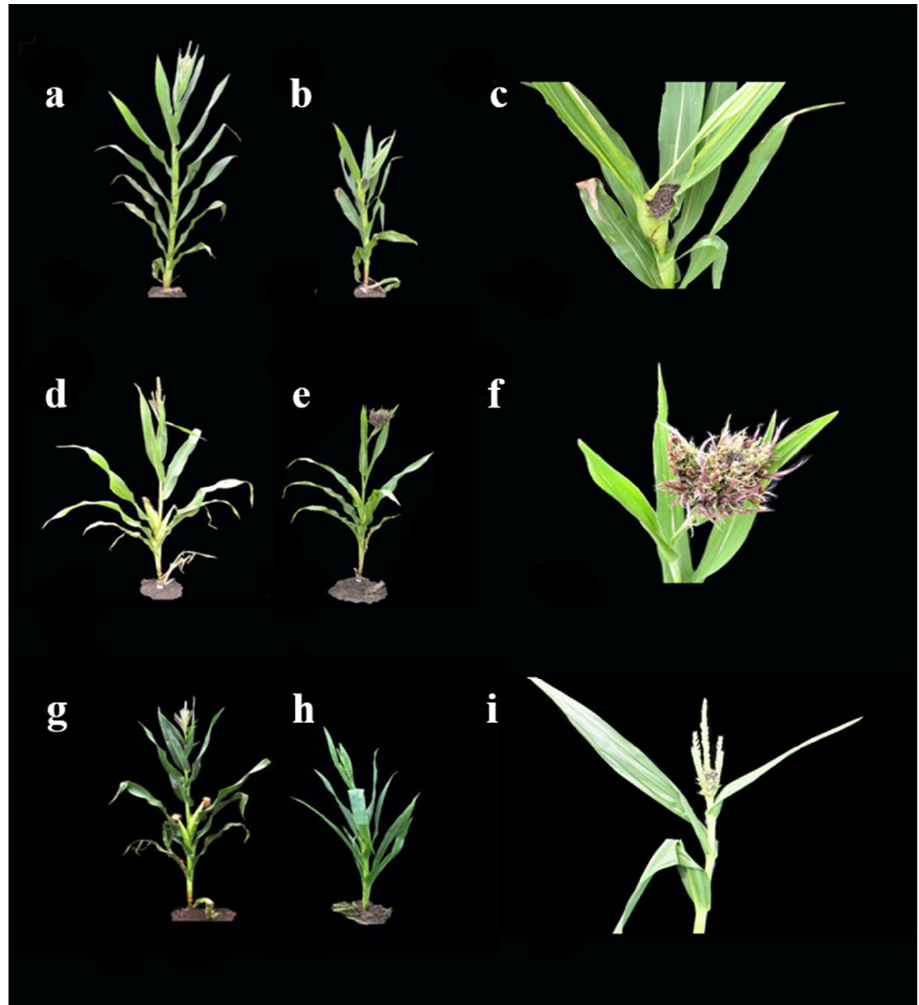
Figure 2. Three types of tassel symptoms in typical maize inbred lines infected with Sporisorium reilianum : ( a ) Huangzao4 normal plant without Sporisorium reilianum ; ( b ) Huangzao4 plant infected with Sporisorium reilianum ; ( c ) Class A with typical symptoms of the tassel of Huangzao4; ( d ) Jing7 normal plant without Sporisorium reilianum ; ( e ) Jing7 plant infected with Sporisorium reilianum ; ( f ) Class B with typical symptoms of the tassel of Jing7; ( g ) Chang7 ‐ 2 normal plant without Sporisorium reilianum ; ( h ) Chang7 ‐ 2 plant infected with Sporisorium reilianum ; and ( i ) Class C with typical symptoms of the tassel of Chang7 ‐ 2.